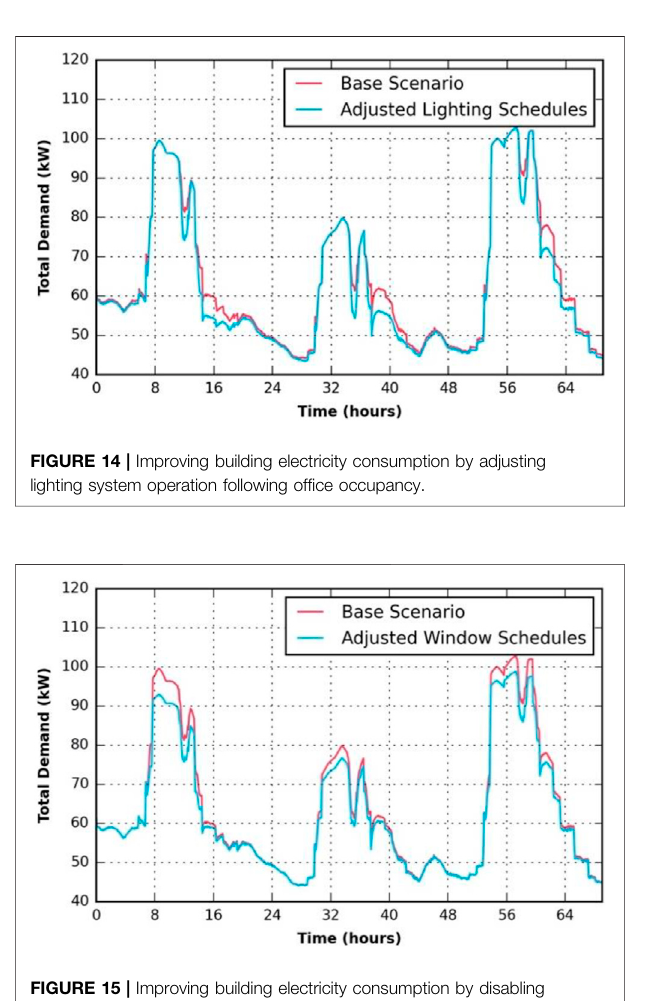
FIGURE 15 | Improving building electricity consumption by disabling operable windows.